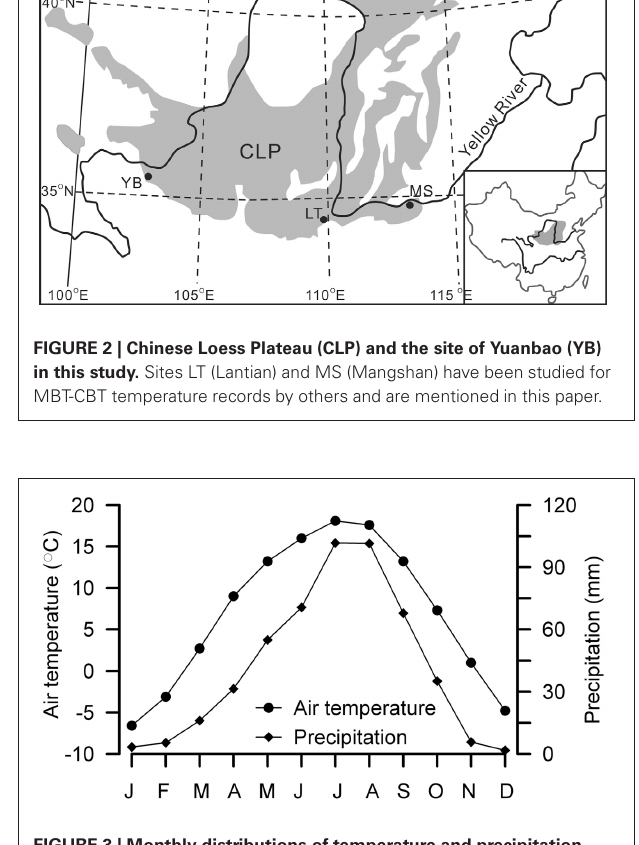
FIGURE 3 | Monthly distributions of temperature and precipitation between 1971 and 2000 at the Linxia city. Data are from Public Meteorological Service Center, China Meteorological Administration. Note that the Yuanbao section is about 500m above the Linxia